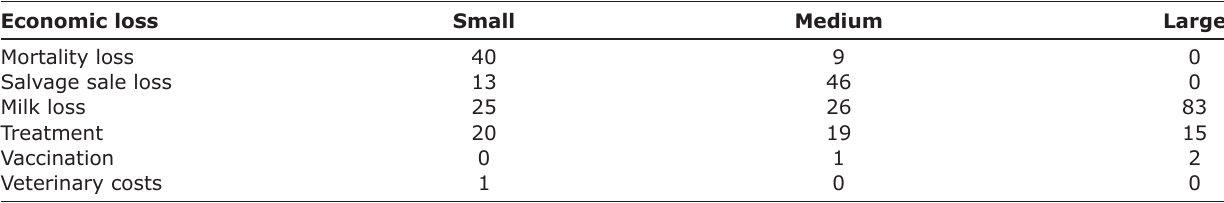
Table-12: The percentage of each economic cost to total FMD cost in Isingiro district.